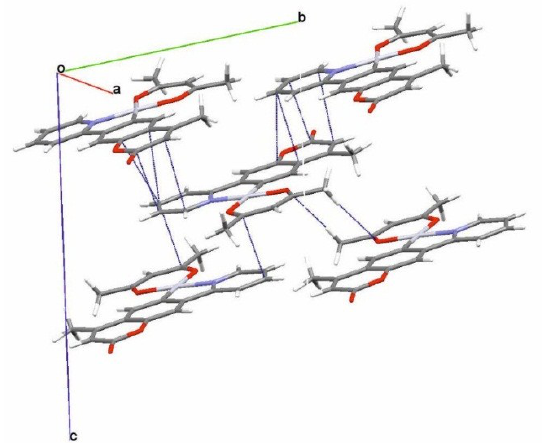
Figure 3. Packing of individual molecules of complex 2 in the crystal, displaying the different interactions of the molecule in the middle with four partners belonging to the sheets above and below. Close contacts are indicated by dark blue dotted lines.